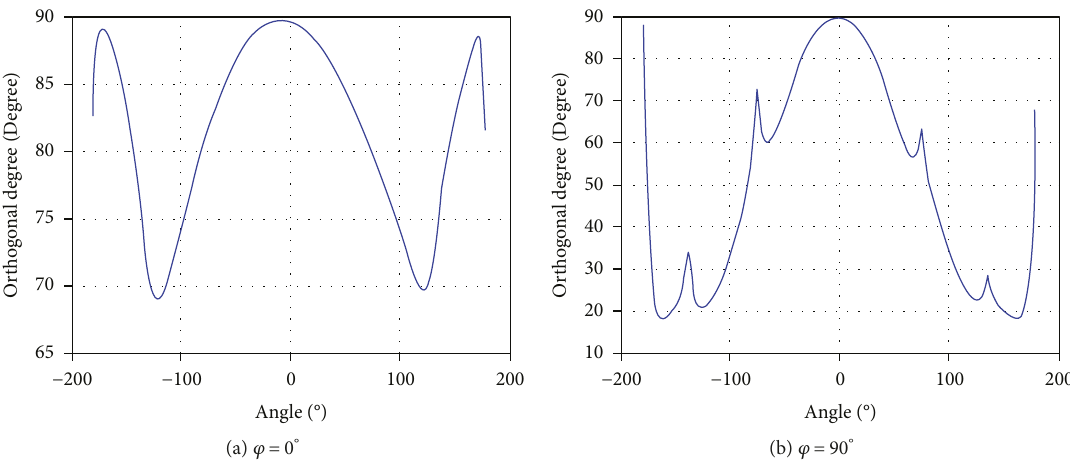
Figure 8: The simulated orthogonal range at the far fi eld space of the designed dual polarized antenna.